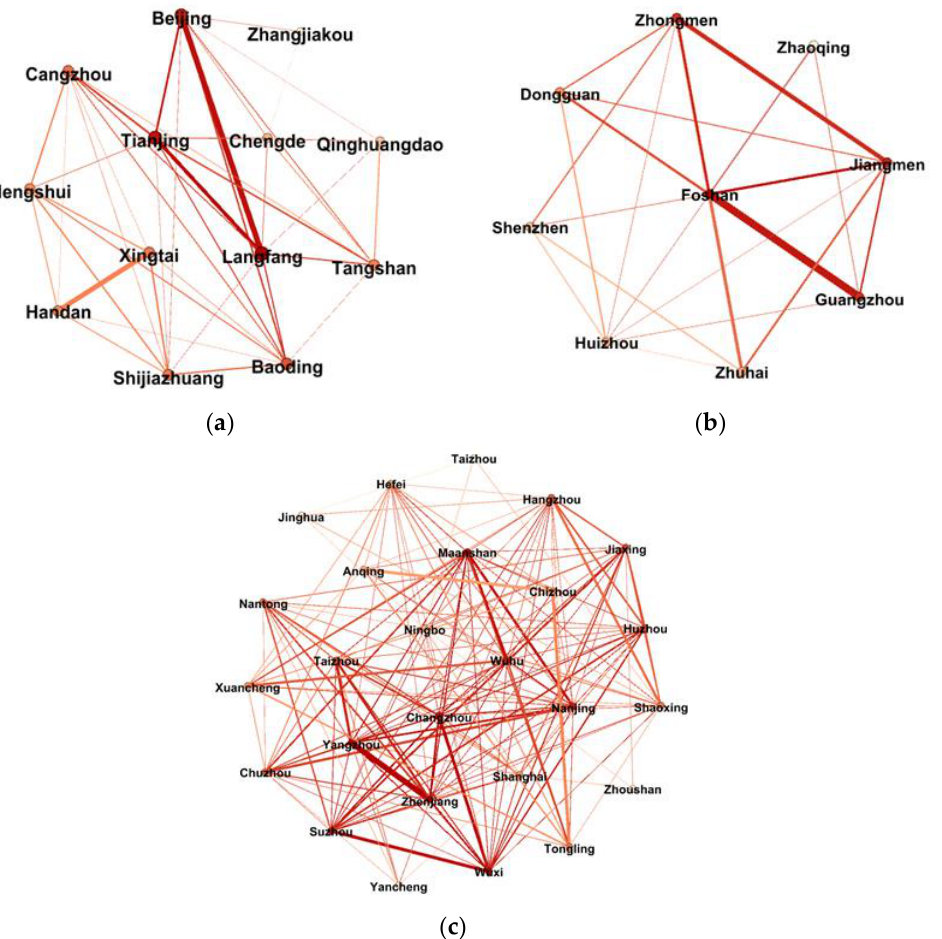
Figure 2. The air pollution spatial correlation weighted networks of the three urban agglomerations: ( a ) Beijing-Tianjin-Hebei; ( b ) Pearl River Delta; and ( c ) Yangtze River Delta.